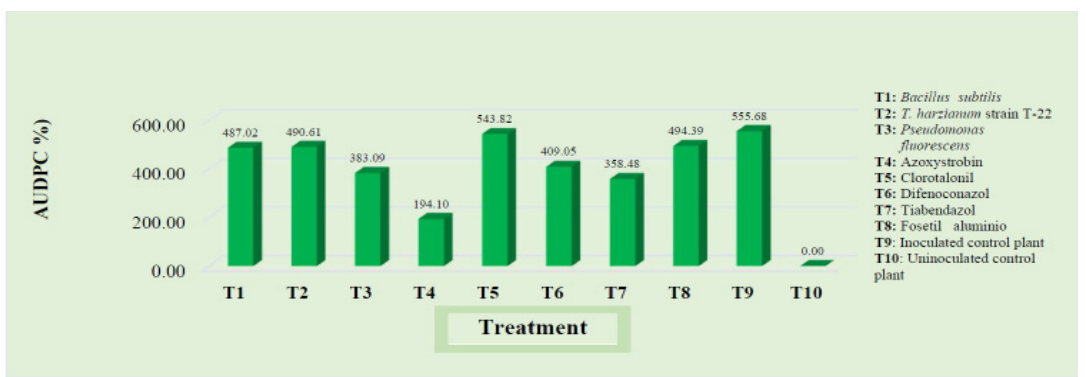
Figure 6. Average area under the disease progress curve (AUDPC) for different treatments used to control leaf spot in strawberry ( Fragaria ananassa ) under greenhouse conditions.. Table 11. Results of the analysis of variance for the average values of the area under the disease progress curve (AUDPC) for leaf spot in strawberry ( Fragaria ananassa ) plants with different treatments under greenhouse conditions..